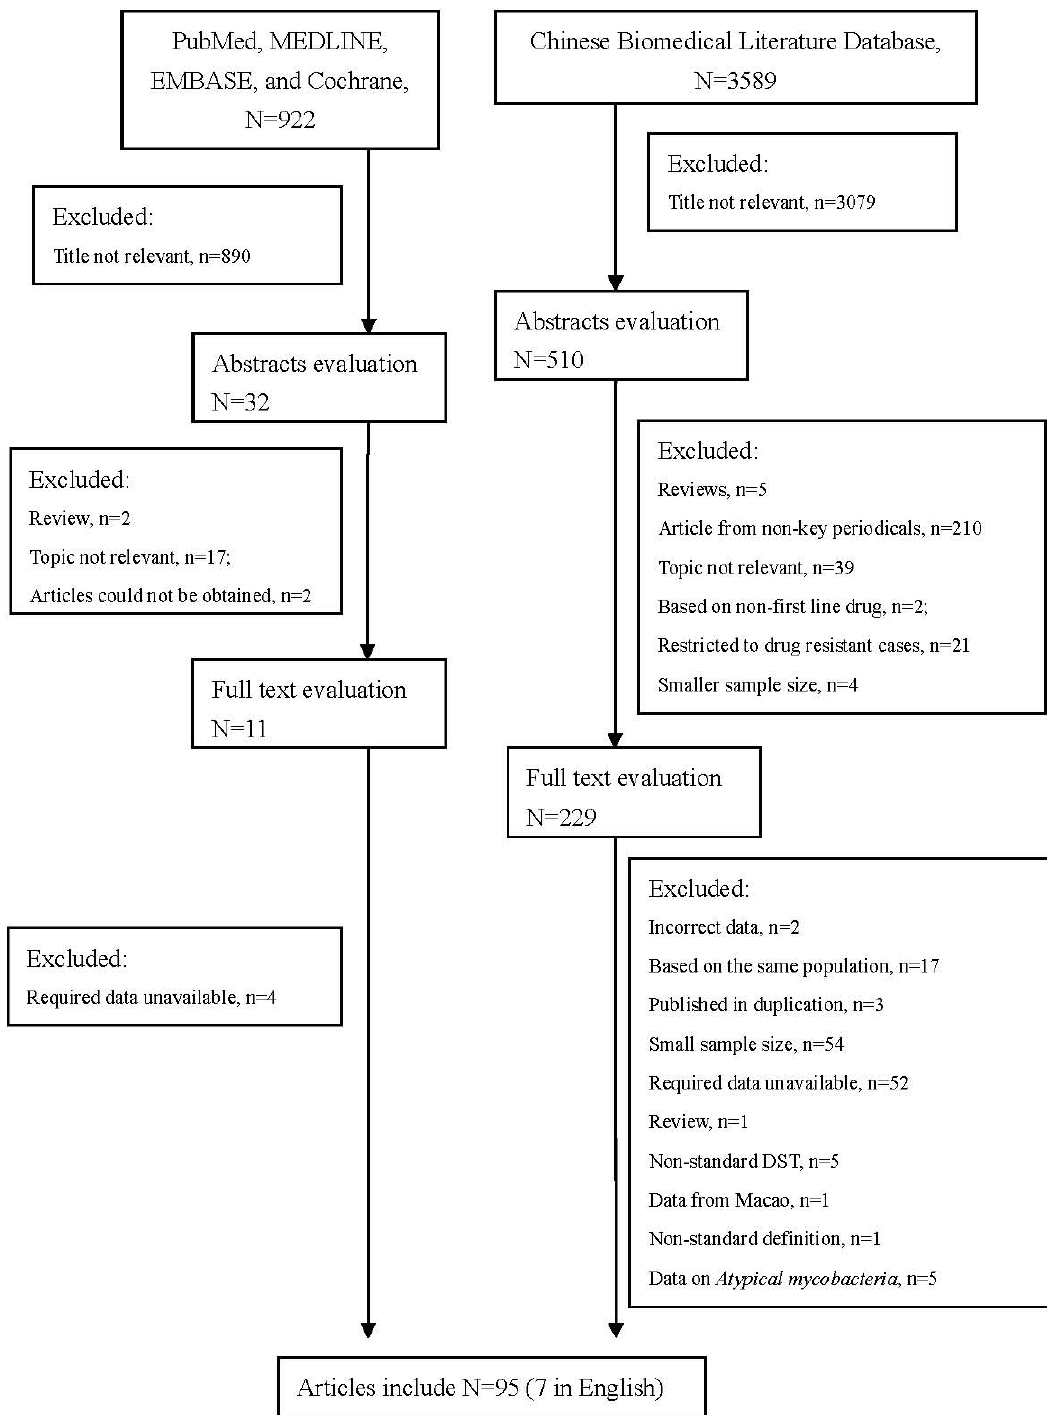
Figure 1. Flow diagram of study identification.